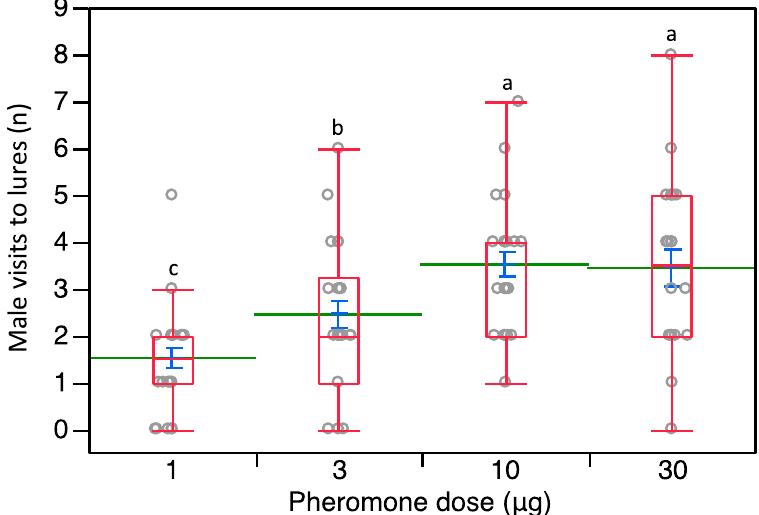
Figure 4. Distribution of P. calceolariae male visits to 16 lures organized in four rows with increasing loadings of sex pheromone going upwind (1, 3, 10, and 30 µ g). Box plots indicate the median (line) within each box and the range of dispersion (lower and upper quartiles and outliers). Green lines and blue T-bars indicate means and standard errors, respectively. Above each box plot, different letters indicate significant differences (Steel-Dwass test, p < 0.05).